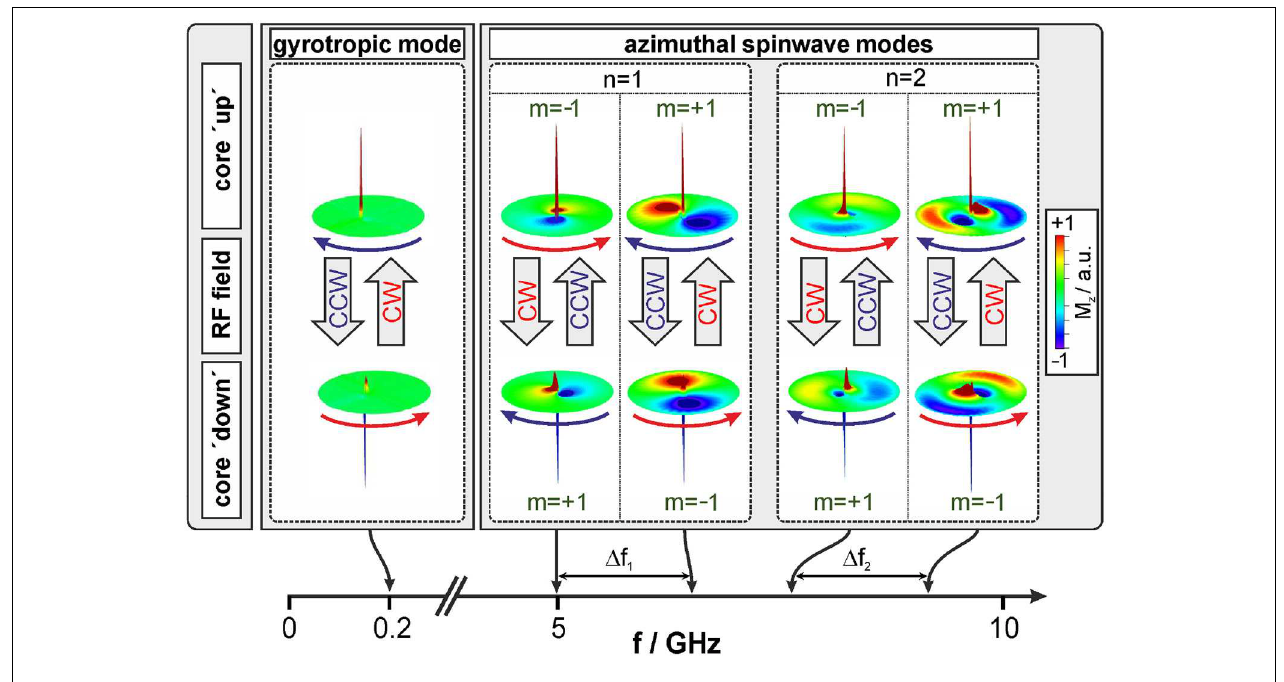
FIGURE 2 | Unidirectional vortex core reversal by excitation of the (sub-GHz) gyromode or (multi-GHz) azimuthal spin waves with external rotating magnetic fields [ 3]. Using 24 periods for